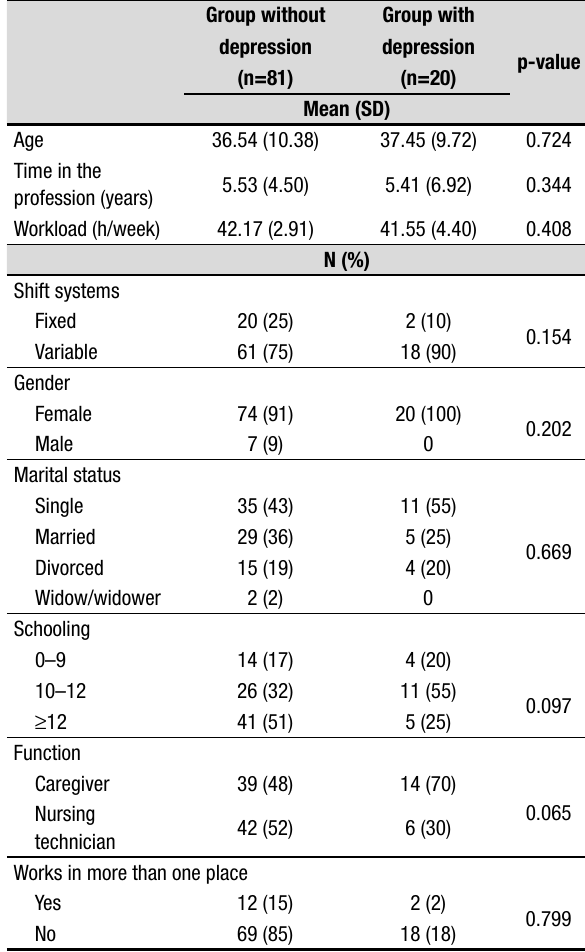
Table 1. Sociodemographic data of the participants, stratified by groups with and without depression.